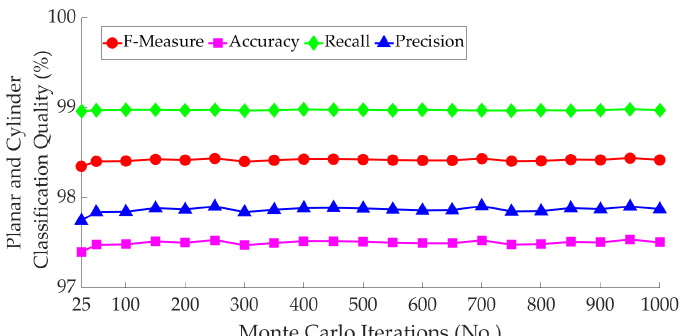
Figure 12. Quality of point-to-model designation using Algorithm 2 vs. the number of iterations.